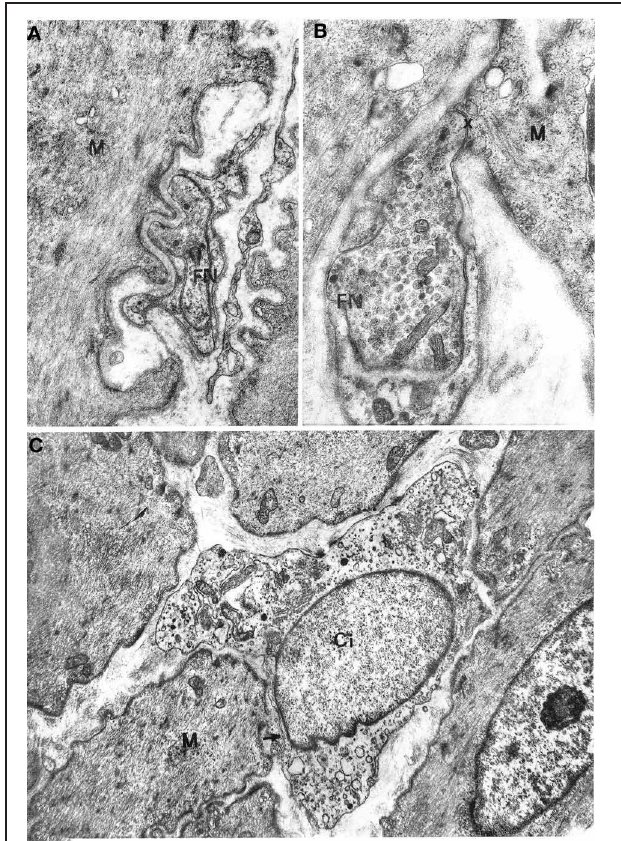
FIGURE 2 | (A,B) Gastric muscle coat. A nerve ending (FN) is shown in (A) at a distance of about 1000Å from a muscle cell (M) with a single basal lamina interposed; × 17000. A close neuromuscular junction (asterisk) between a nerve fiber (FN) and a muscle cell (M), with no basal lamina interposed, is shown in (B) × 19,500. (C) Oesophageal muscle coat. Ci: interstitial cell with cytoplasm rich in smooth endoplasmic reticulum. The cell virtually lacks a basal lamina. The arrow points to a close contact with a muscle cell (M). × 8600.